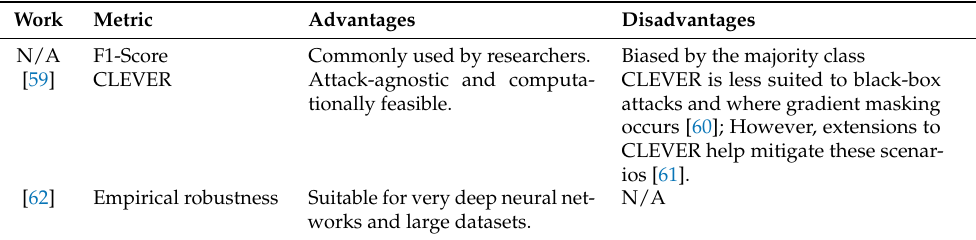
Table 2. Robustness